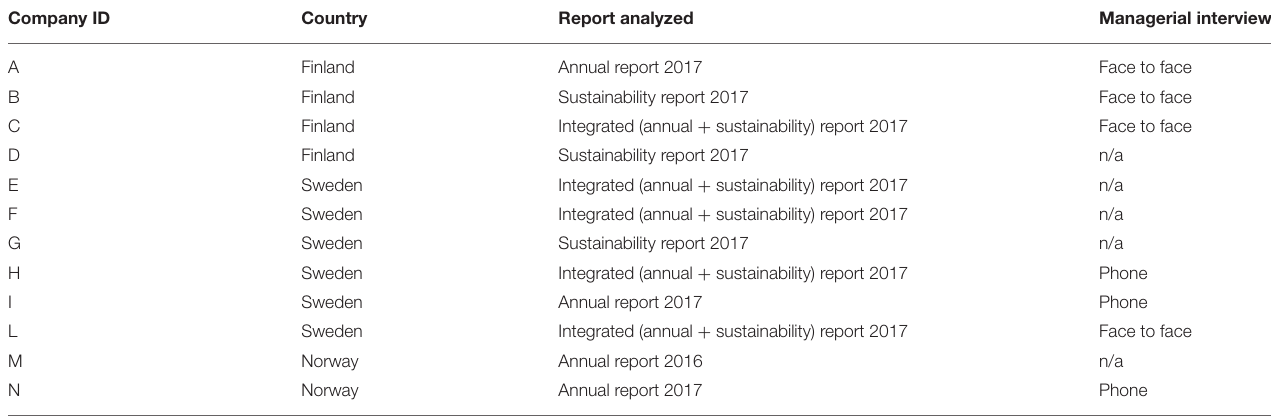
TABLE 3 | Data sources for the study, including disclosure material and managerial interviews with representatives of the 12 Nordic forestry companies featured among the 100 largest forest, paper and packaging companies in the world by sales revenue (PWC, 2016). Company